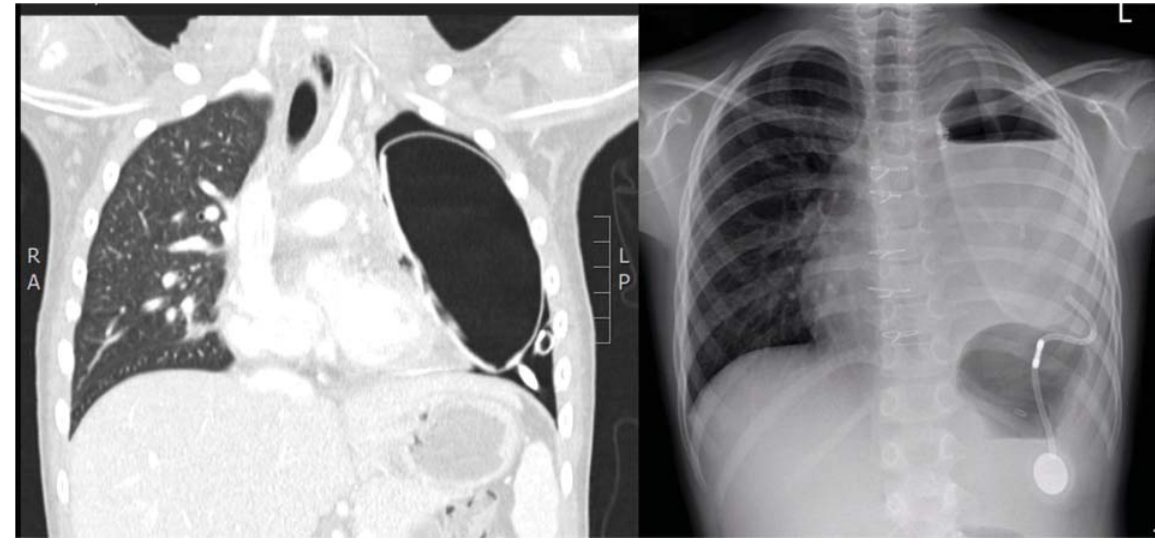
Fig. 2 Postoperative